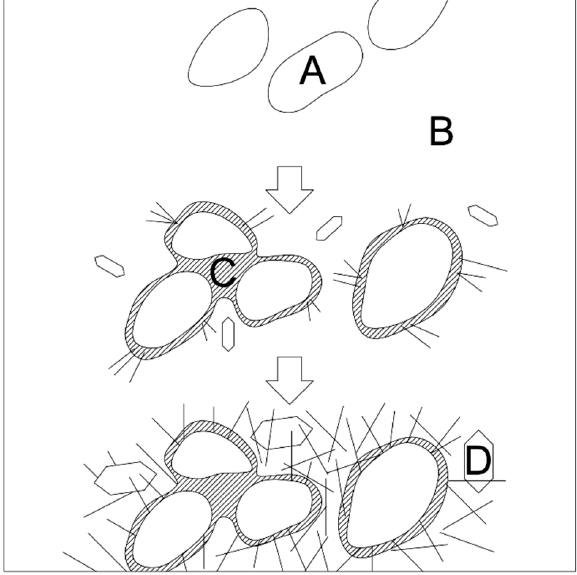
Figure 6. Hydration of Portland cement in the absence of micro silica addition (A—Portland cement; B—water; C— CSH ; D— CH ).